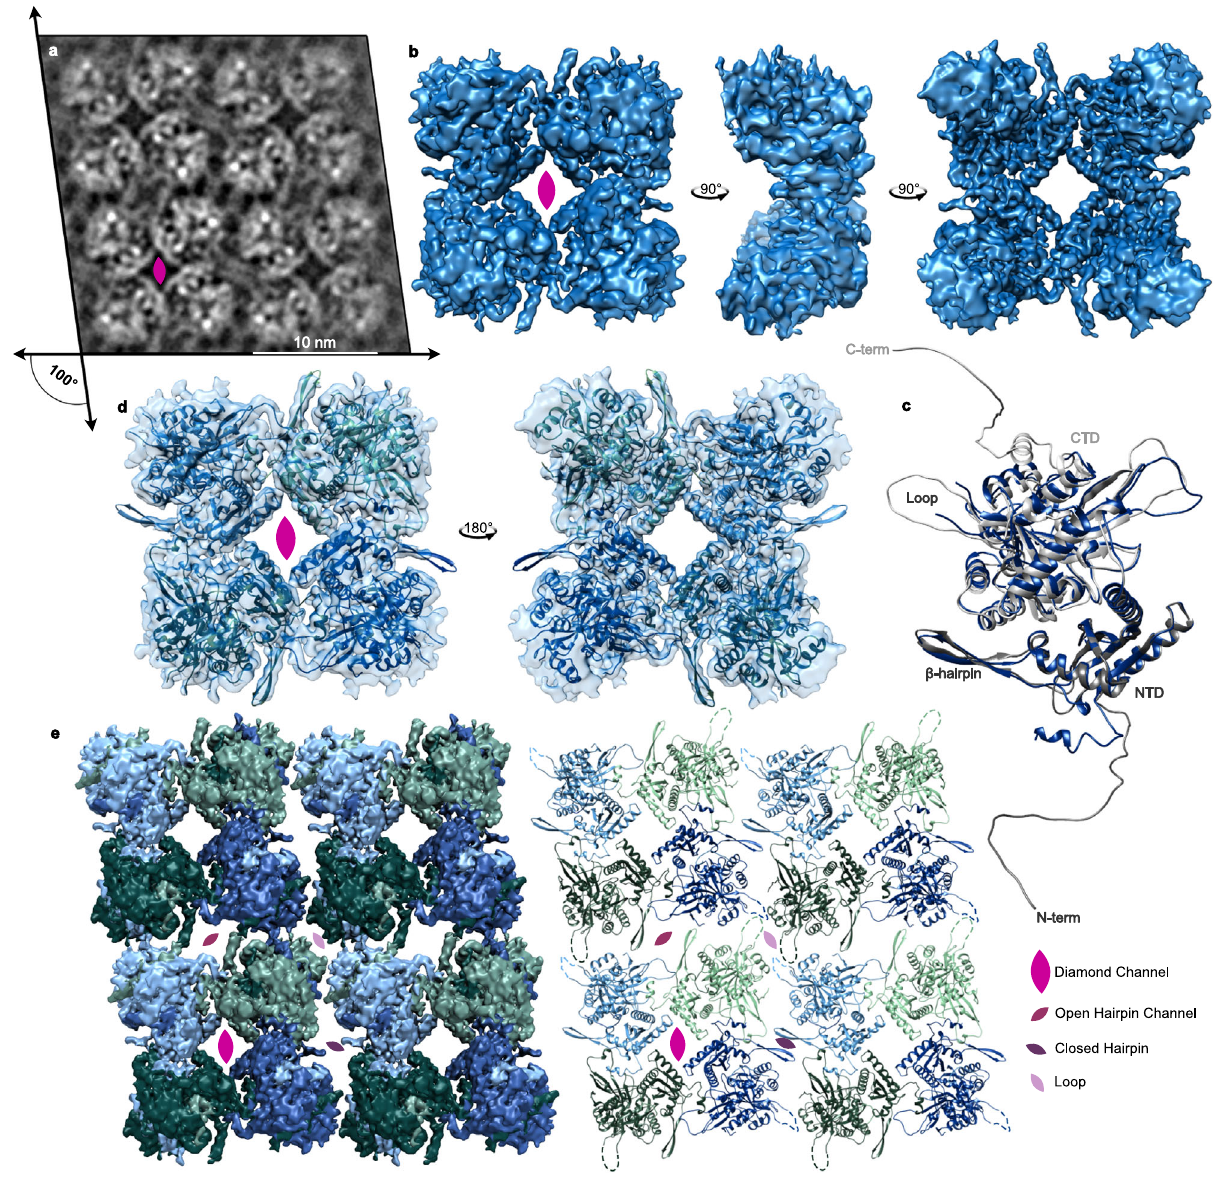
Fig. 2 | PhuN assembles into a p2 symmetric lattice. a Example 0° tilt 2D class average highlighting the p2 symmetryand resulting in four unique interfaces. The lattice is skewed to an ~100° angle. The positioning of the fl exible loops that are dif fi cult to resolve in 3D is visible. b Highest resolution map of the core tetramer centered on the Diamond channel as viewed from different angles. c The fi nal PhuN-C subunit model (blue) overlaid with the AlphaFold prediction used as our startingmodel(gray).Residues1 – 18,276 – 287,and556 – 602hadnocorresponding